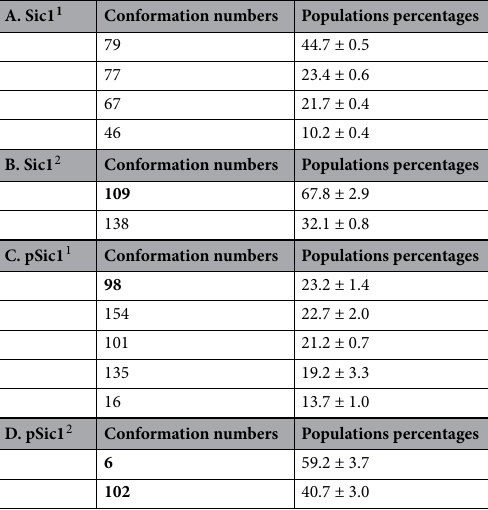
1 2 , 2 for Sic1 , 3 for